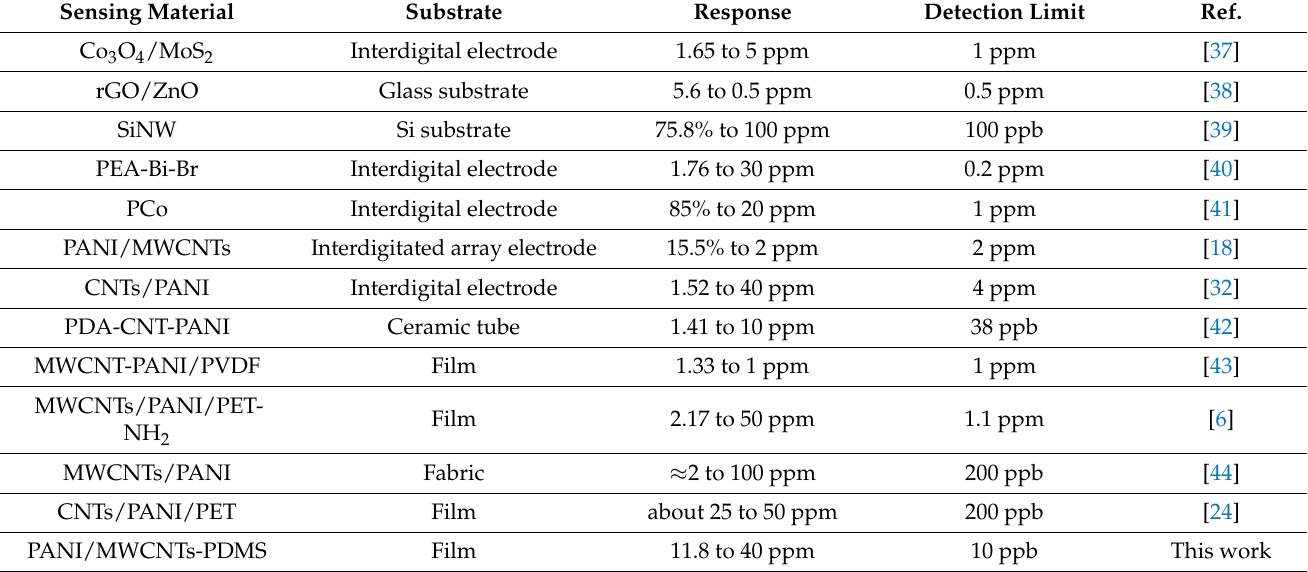
Table 1. NH 3 sensing performances of gas sensors based on PANI/MWCNTs